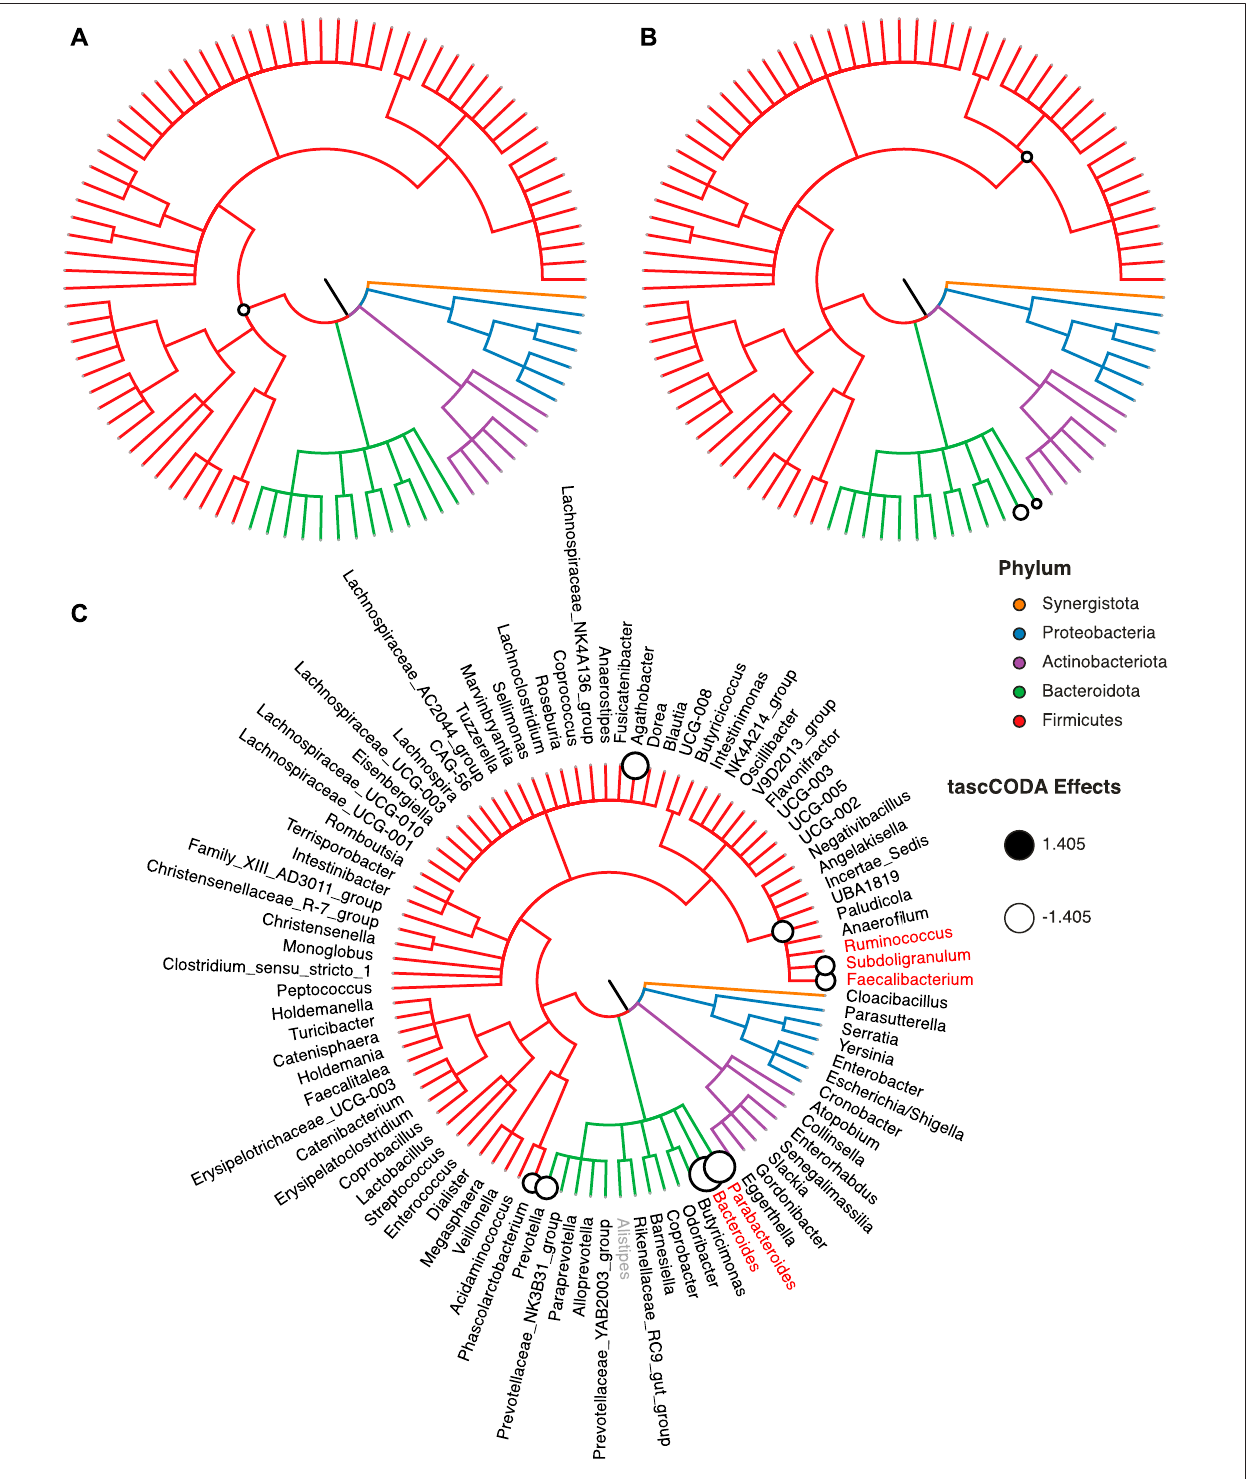
FIGURE 7 | Credible changes found by tascCODA ( λ 1 (cid:2) 1), comparing healthy controls and IBS patients in the genus-aggregated data of Labus et al. (2017). The circles on nodes of the tree represent credible effects. (A) High-level aggregation with ϕ (cid:2) − 5. (B) Unbiased aggregation ( ϕ (cid:2) 0). (C) Aggregation with bias towards the leaves ( ϕ (cid:2) 5).Redgenerashowthecredibleeffects foundbyscCODA(FDR (cid:2) 0.1)onthegenuslevel.Thegrey genus Alistipes wasused asthereferencefortascCODA and scCODA.